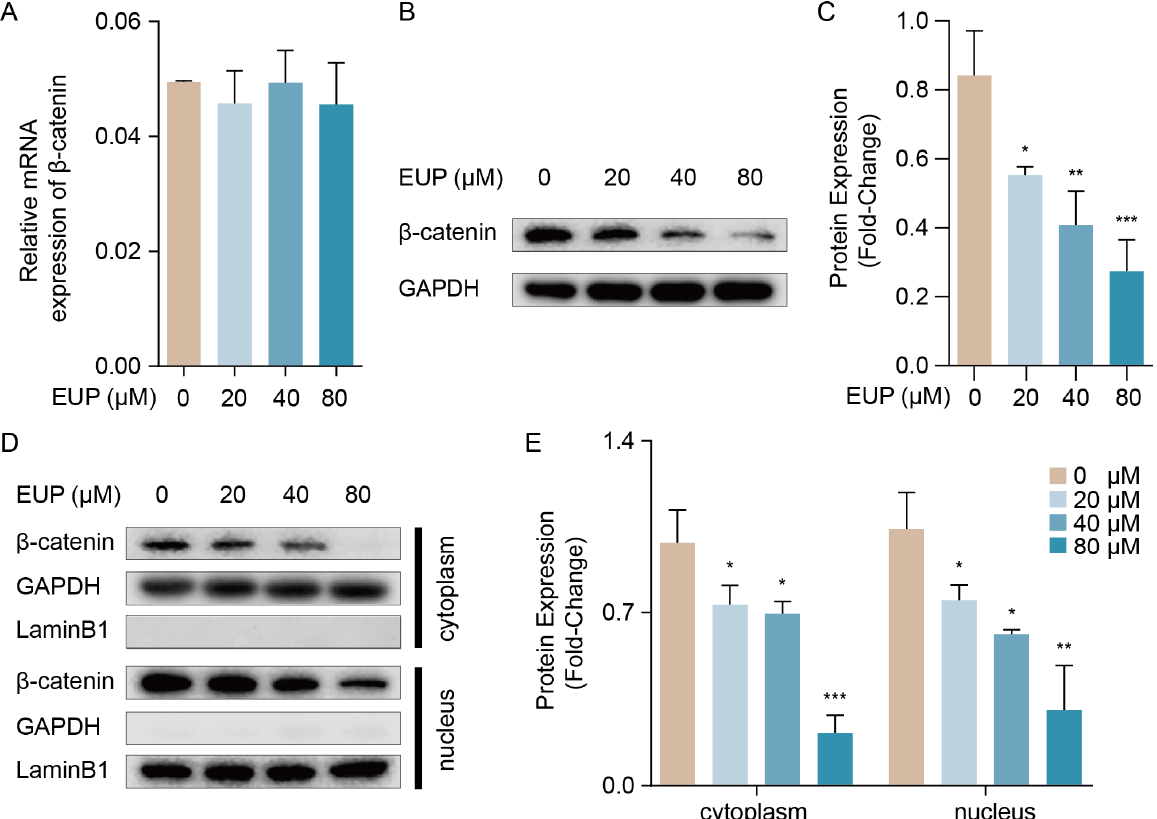
Figure 5. Eupatilin inhibits β -catenin signalling pathway. ( A ) Relative mRNA expression of β -catenin in LX-2 cells treated with eupatilin (mean ± SD, n = 3). ( B ) Western blot analysis of β -catenin in LX-2 cells treated with eupatilin. ( C ) Relative protein signal intensity of Figure 5B was quantified as mean ± standard deviation (mean ± SD, n = 3). ( D ) Western blot analysis of β -catenin protein in both cytoplasm and nucleus. ( E ) Relative protein signal intensity of Figure 5D was quantified as mean ± standard deviation (mean ± SD, n = 3). The mRNA and proteins detection were preformed 48 h after eupatilin treatment. p values are calculated by one-way ANOVA followed by the Tukey’s test. * p < 0.05, ** p < 0.01 and *** p < 0.001 vs. 0 μ M EUP group. EUP: Eupatilin; GAPDH: Glycer-